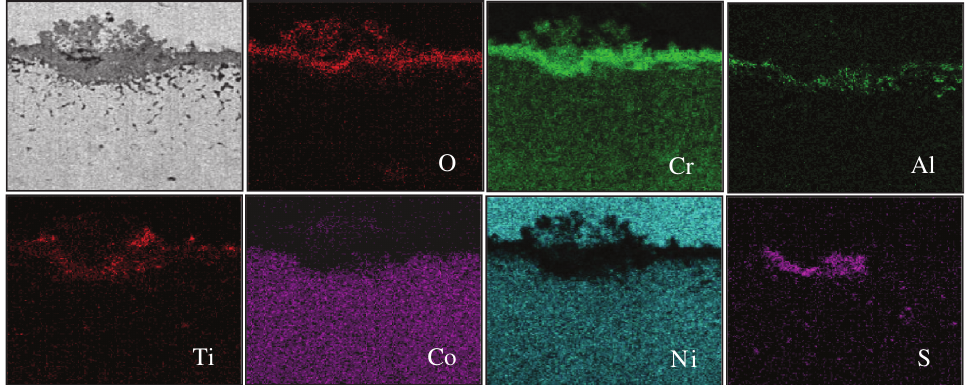
Figure 7: EDS elemental mapping analysis of the corroded samples at 750°C for 500h with 1.5% SO 2 + NaCl